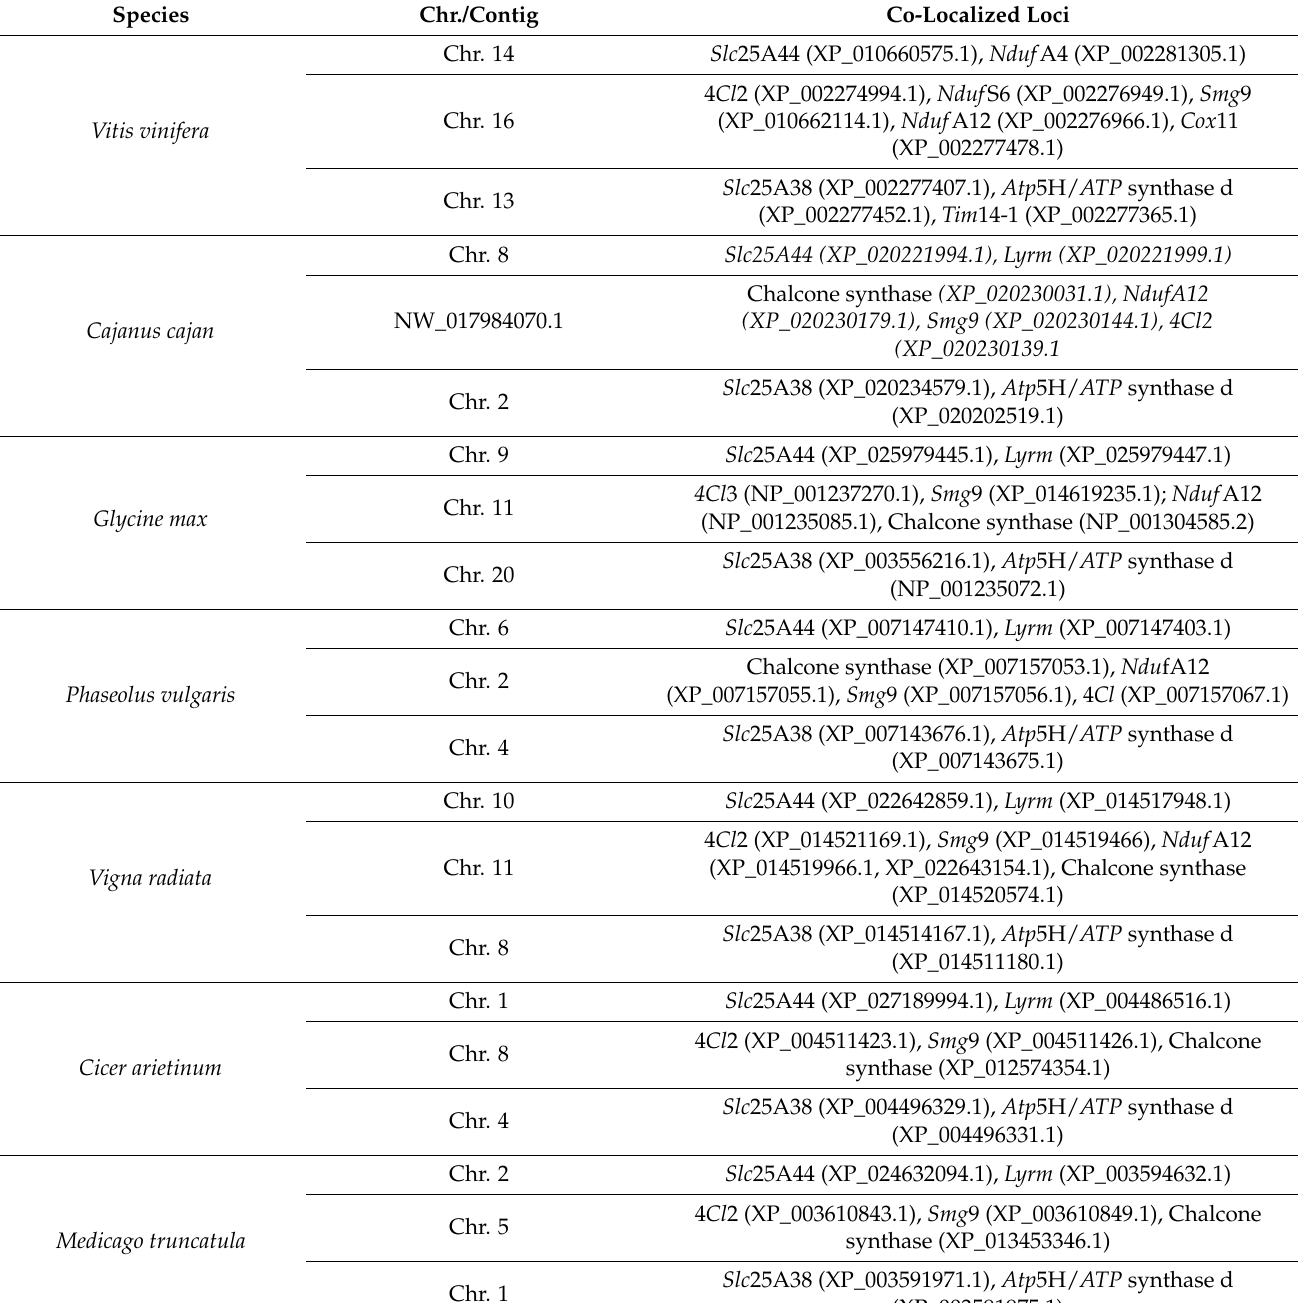
Table 1. The identified genomic co-localizations for Slc25A44, Slc25A28, Slc25A38 , and fungal Agc 1. Species